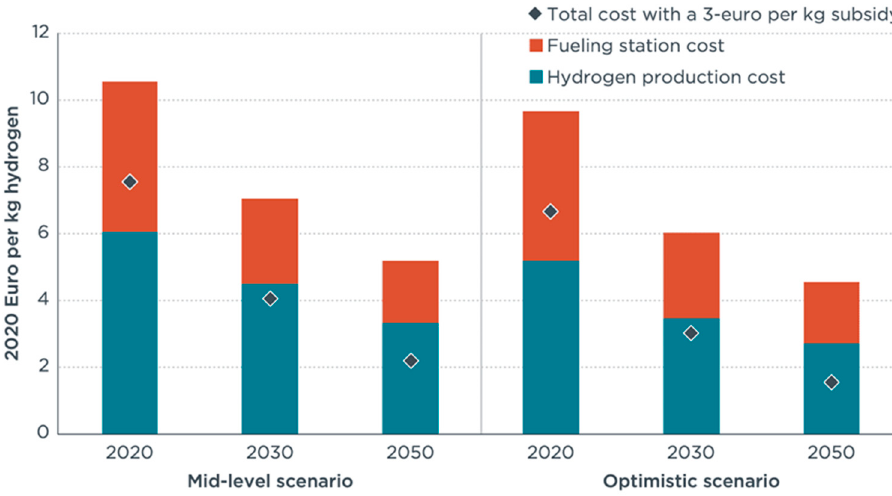
Figure 5. The average price of hydrogen at the pump in 26 EU countries, based on the mid-level cost scenario and the optimistic cost scenario [57].